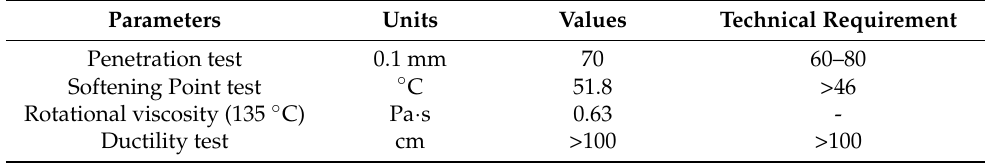
Table 1. Technical information of base asphalt.